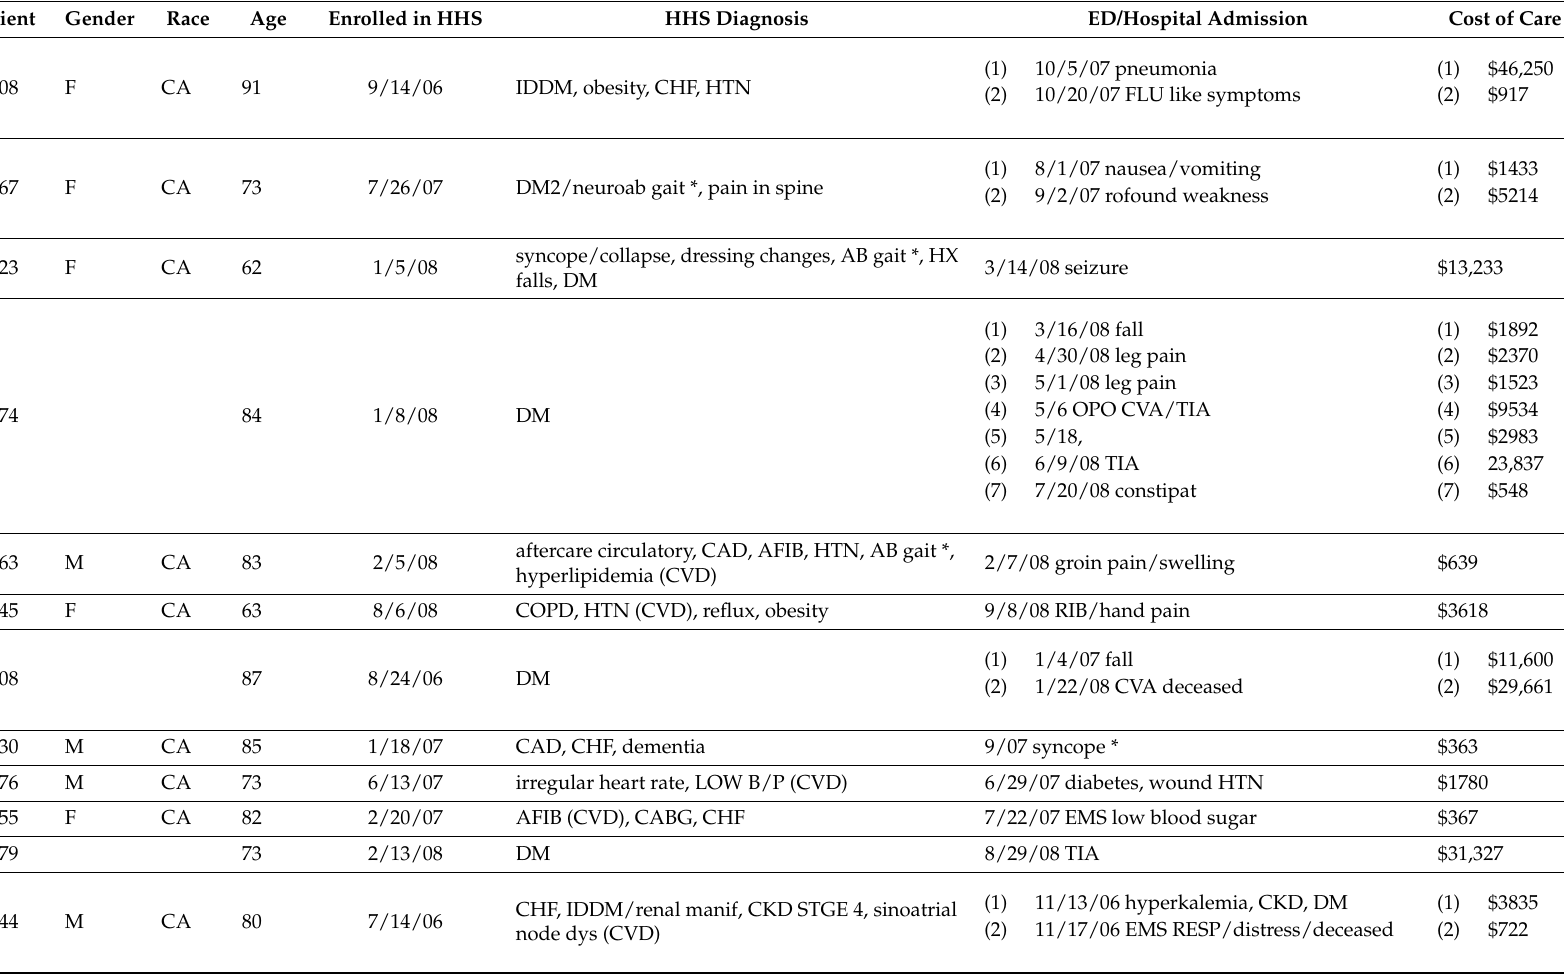
Table 5. Gender, Race, Age, HHS Enrollment Dates, HHS Diagnosis, Causes and Costs of Emergent Care of Comparison Patients ( N = 22/36,